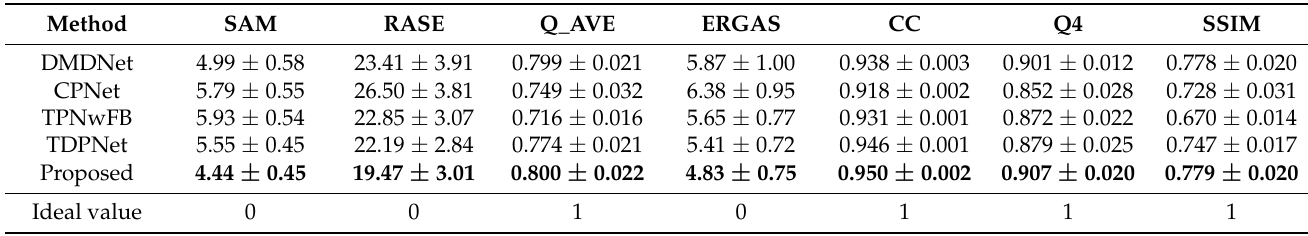
Table 7. Evaluation results of deep learning methods trained on QuickBird and tested on WorldView-3 (best results is in bold).